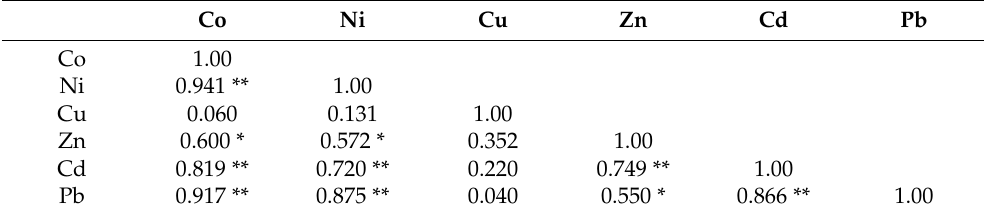
Table 5. Pearson correlation analysis results of heavy metals in the soil. Co Ni Cu Zn Cd Pb Co 1.00 Ni 0.941 ** 1.00 Cu 0.060 0.131 1.00 Zn 0.600 * 0.572 * 0.352 1.00 Cd 0.819 ** 0.720 ** 0.220 0.749 ** 1.00 Pb 0.917 ** 0.875 ** 0.040 0.550 * 0.866 **